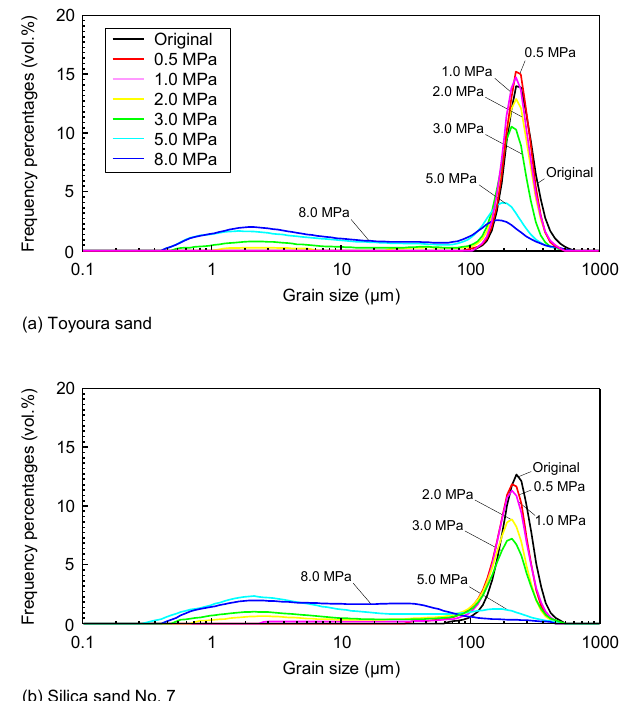
Figure 8. Grain size frequency distribution curves for the shear zones of ( a ) Toyoura sand and ( b ) silica sand No. 7